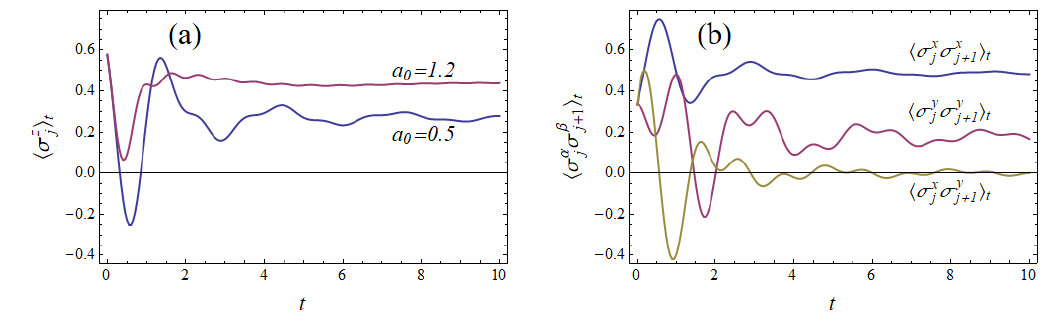
Figure 1: Time dependence of observables in the transverse field Ising model, see eqs. (21)-(23). The initial state is a product translation-invariant state (19) with the polarization p a specified in the plot. (b) 〈 σ x 0 = a 0